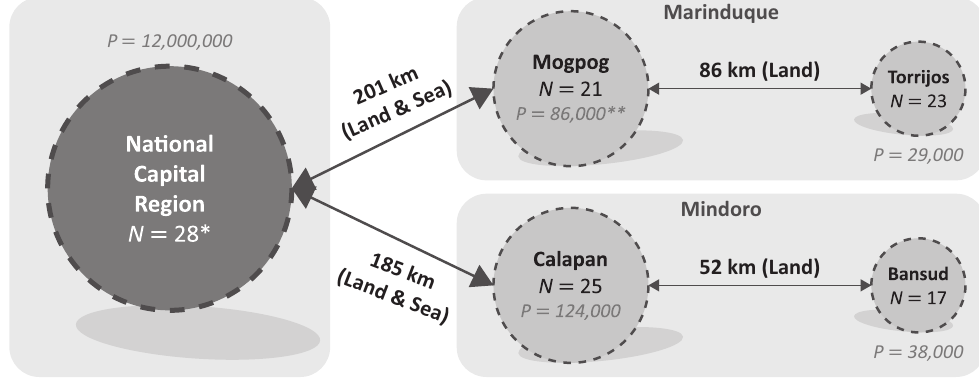
Figure 5. Survey area selection schema based on the study’s conceptual framework. this small sample (due to safety reasons in distributing the survey). Figure 5 details the number of individual responses that were collected in each survey area: Calapan City ( N = 25), Mogpog/Boac ( N = 21), Torrijos ( N = 23), Bansud ( N = 17) and the National Capital Region as a reference ( N = 28), collected over a two week period ( N =